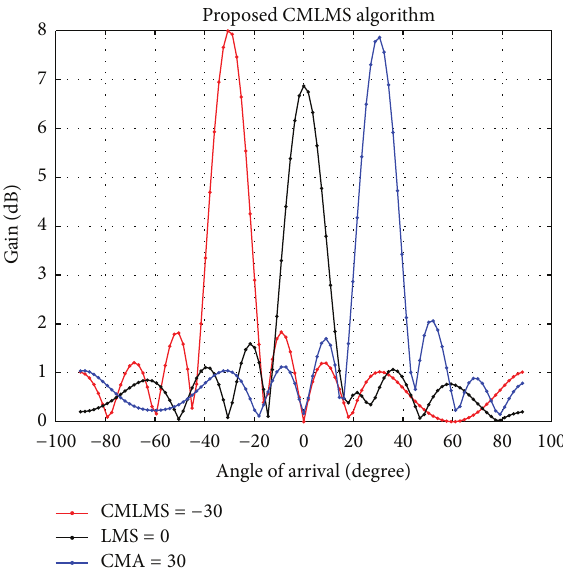
Figure 5: Beam patterns achieved by CMLMS, LMS, and CMA algorithms.